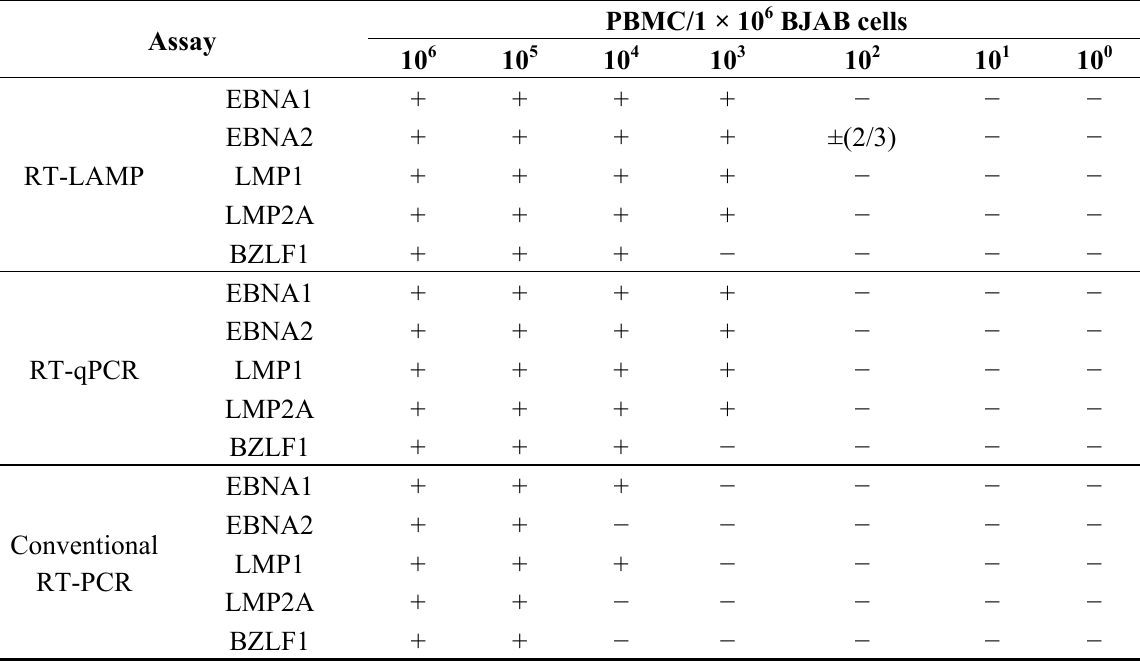
Table 2. Sensitivity tests of RT-LAMP, RT-qPCR and conventional RT-PCR methods using PBMC from positive